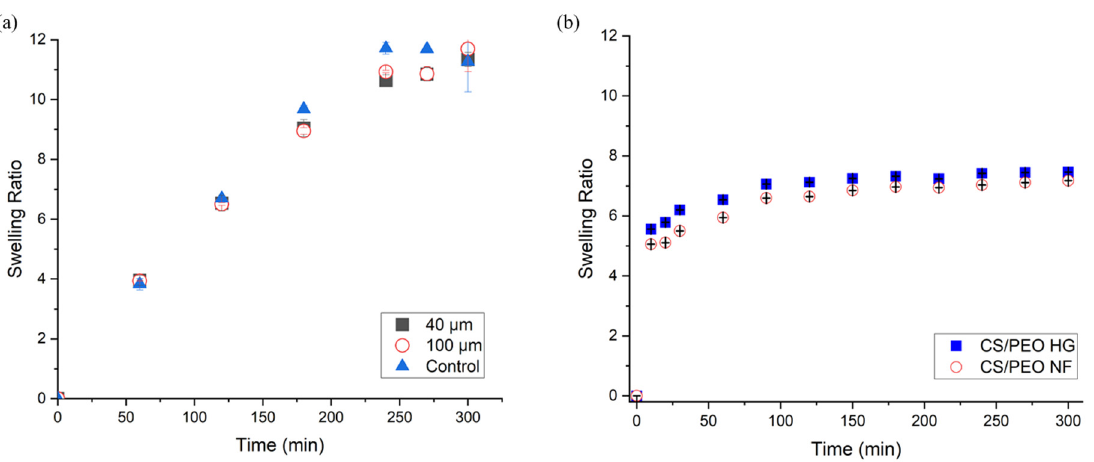
Figure 4. Swelling ratio of ( a ) PUAA hydrogel films (a flat bulk unstructured hydrogel film was used as the control) and ( b ) CS/PEO based hydrogels and nanofibers.